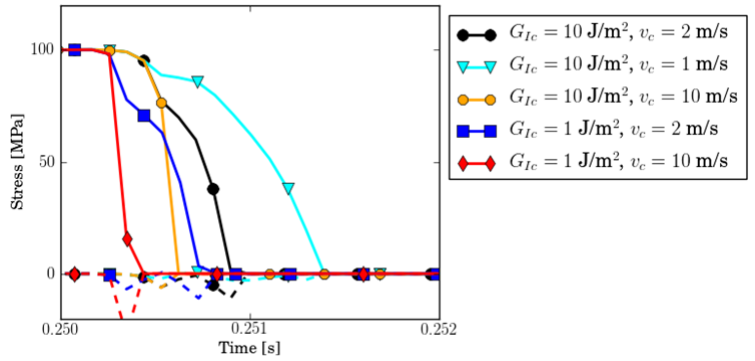
Fig. 10 Stress decay of failing element for model with three unit elements using a crack delay model; solid and dashed lines for stress components orthogonal and parallel to the crack face respectively.